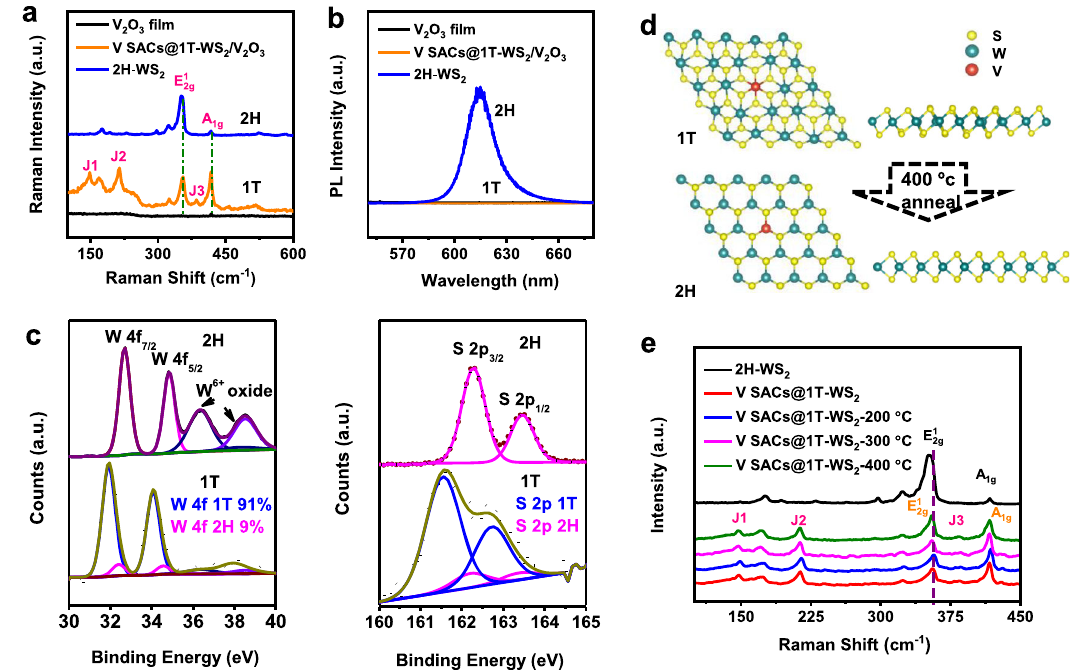
Fig. 3 Phase transition from 1T to 2H. a Raman spectra of V 2 O 3 fi lm (black), V SACs@1T-WS 2 /V 2 O 3 (orange), and 2H-WS 2 (blue). b PL spectra of V 2 O 3 fi lm (black), V SACs@1T-WS 2 /V 2 O 3 (orange), and 2H-WS 2 (blue). c High-resolution XPS spectra of W 4f (left) and S 2p (right) core level peak regions for 2H and 1T phase, respectively. The fi tting blue and pink curves represent the contributions of 1T and 2H phases, respectively. d Schematic representation of the 1T to 2H structural phase transition occurring upon thermal annealing. e Raman spectra of 2H-WS 2 , V SACs@1T-WS 2 , and V SACs@1T-WS 2 with different annealing temperatures in H 2 /Ar for 2